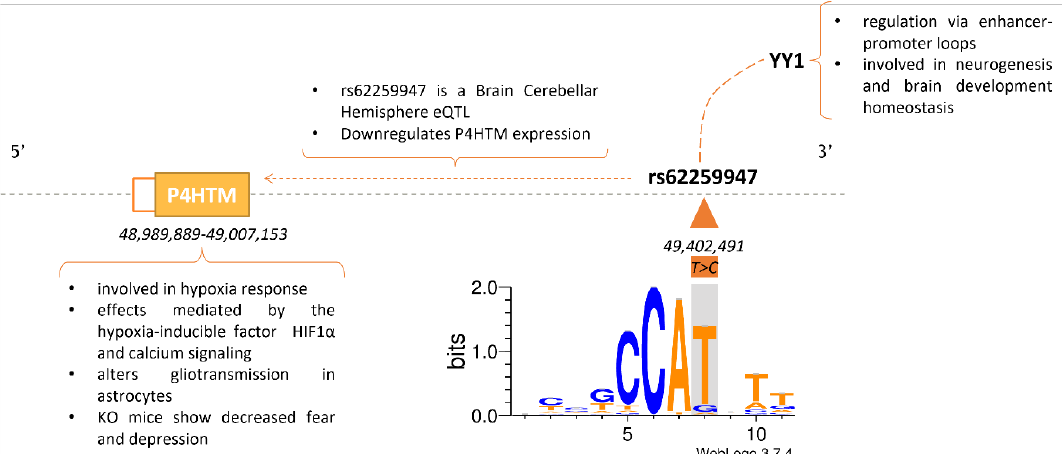
Figure 3. The GV rs62259947 might disrupt the binding of YY1, thus affecting the expression of P4HTM and resulting in behavioral alterations. rs62259947 is an eQTL downregulating the expression of P4HTM and is predicted to disrupt the binding of the TF YY1 . This is represented by the sequence logo of the binding site with the nucleotide change highlighted in grey. YY1 is involved in neurogenesis and, in turn, controls the expression of P4HTM, which is mediated by HIF1α regulates calcium signaling and is also associated with behavior. GV: genetic variant; eQTL: expression quantitative trait loci; TF: transcription factor; KO: knockout.